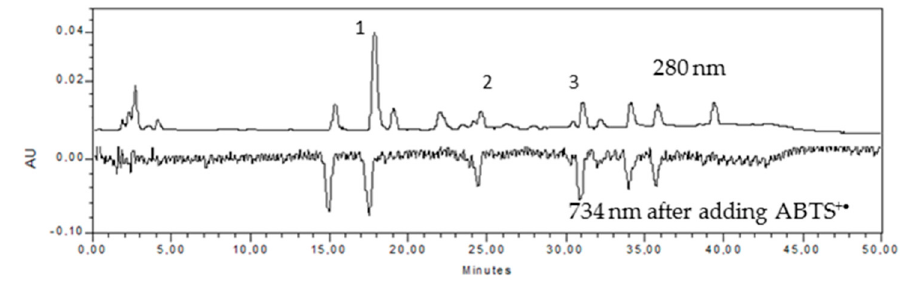
Figure 1. HPLC chromatogram of the extract of ASE. Chlorogenic acid (1), (+)-Catechin (2), ( − )-Epicatechin (3).